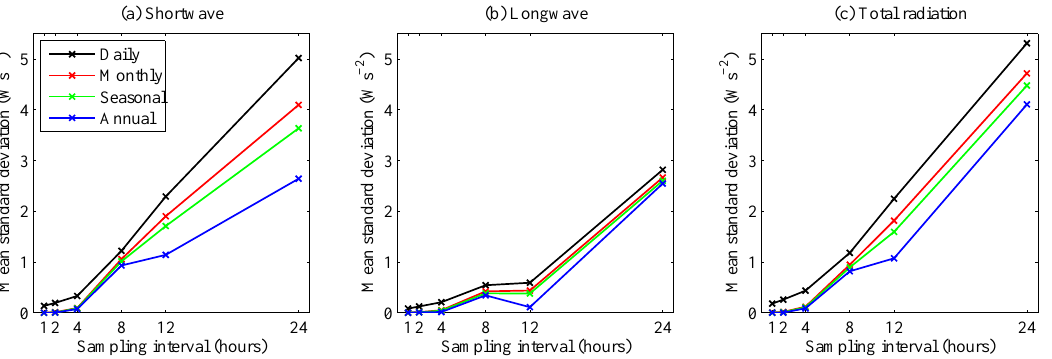
Figure 7. The mean of the standard deviations of the difference between full and subsampled time series σ r , n for ( a ) shortwave; ( b ) longwave and ( c ) total